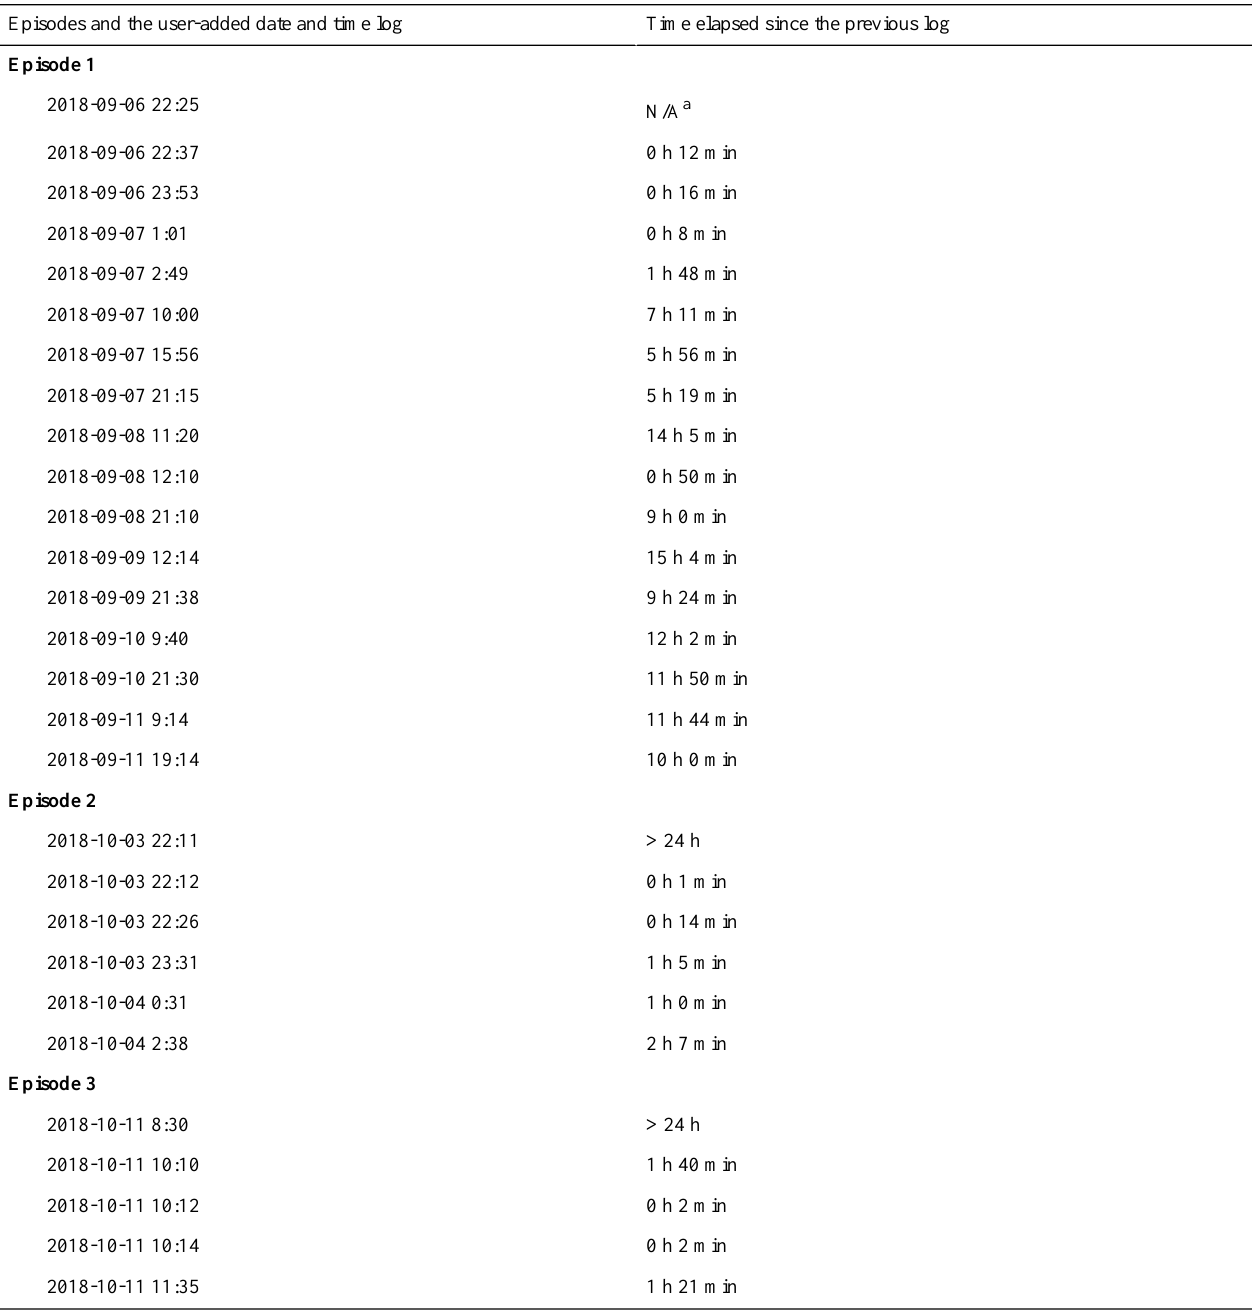
Table 1. Examples of episode